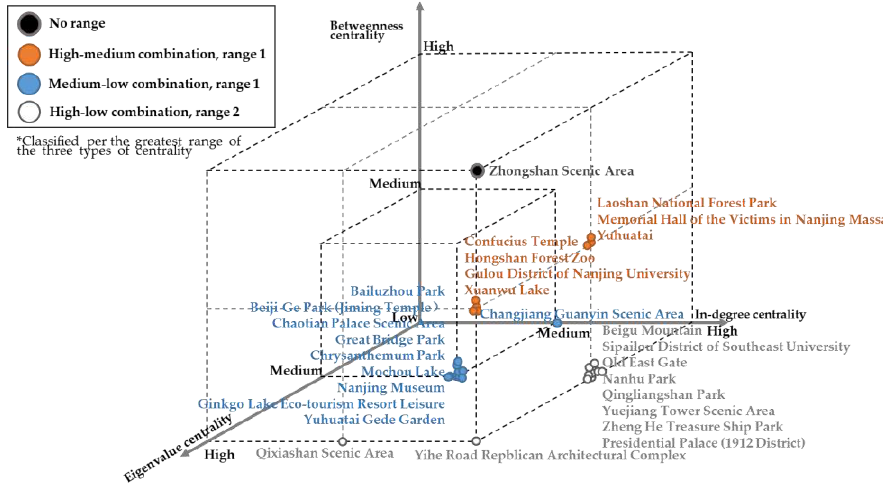
Figure 9. Evaluation of the node status in the overall tourism flow network.